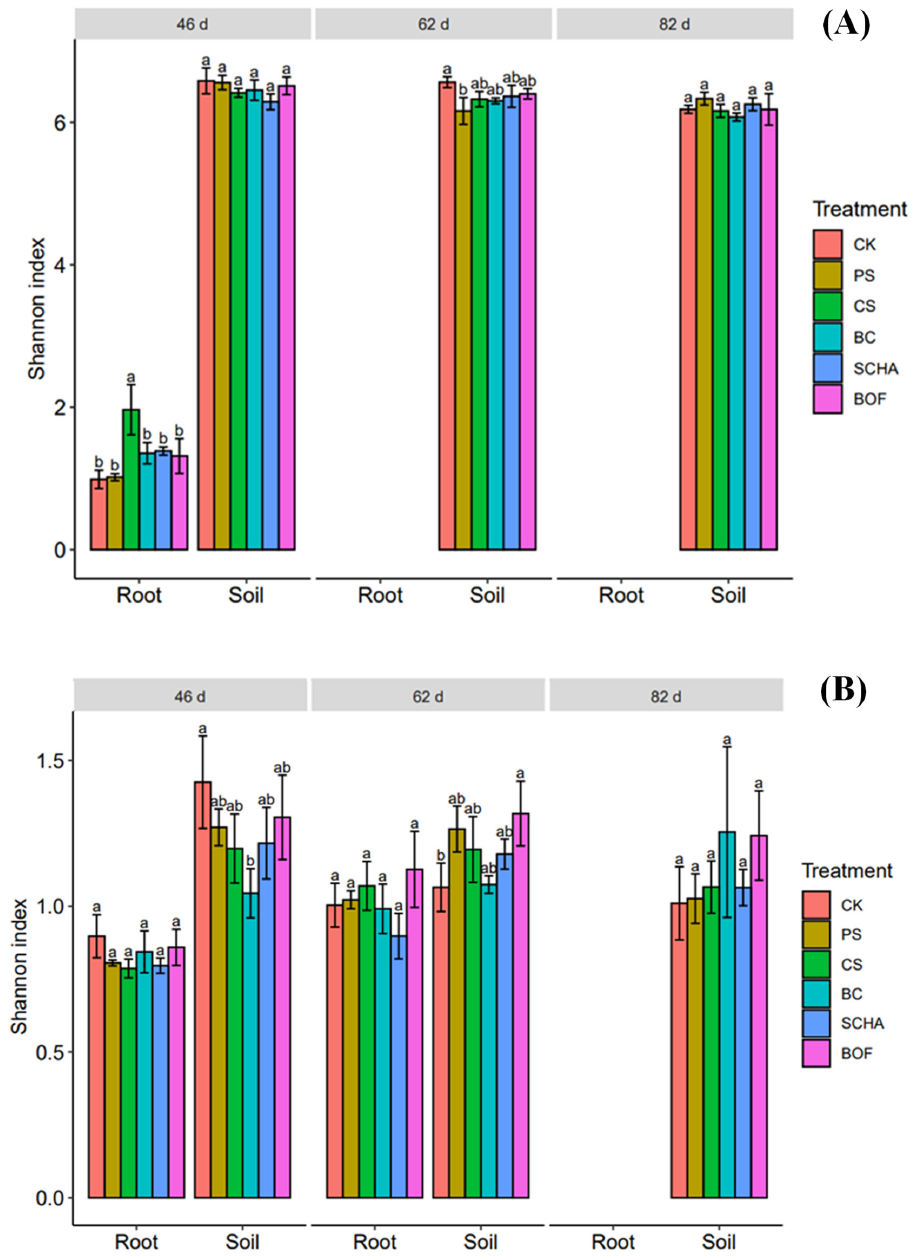
Figure 5. The Shannon index of the soil and root bacteria ( A ) and fungi ( B ) among different treatments at different periods. Different letters represent significant differences among different treatments at the same compartment. Bars indicate standard error ( n = 4). Amendment treatments include CK (no fertilization); PS (potassium silicate); CS (calcium silicate); BC (biochar); SCHA (calcium silicate humic acid); BOF (bio-organic fertilizer).